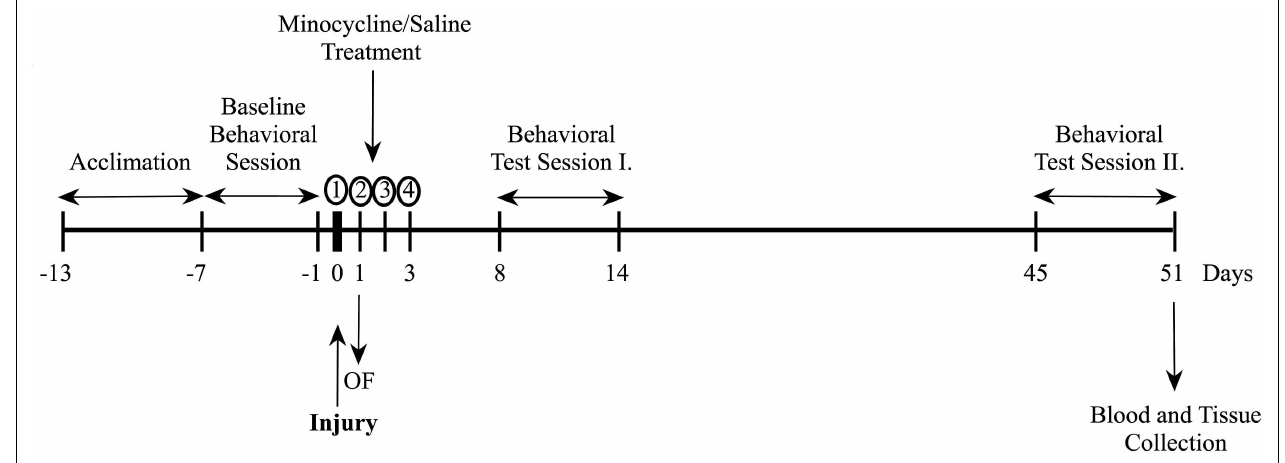
Maze, and Barnes Maze) were conducted before injury (Baseline Behavioral Session), and at 1 (open field OF only), 8 (BehavioralTest Session I.), and 45days (BehavioralTest Session II.) after injury or sham. At the end of the experiment blood and brains were collected, processed, and analyzed using RPPM and